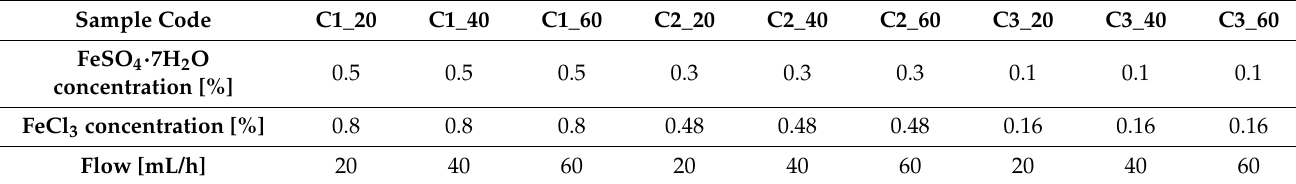
Table 1. The concentration of Fe 2+ and Fe 3+ and the flow of the precursor solution for each sample. Sample